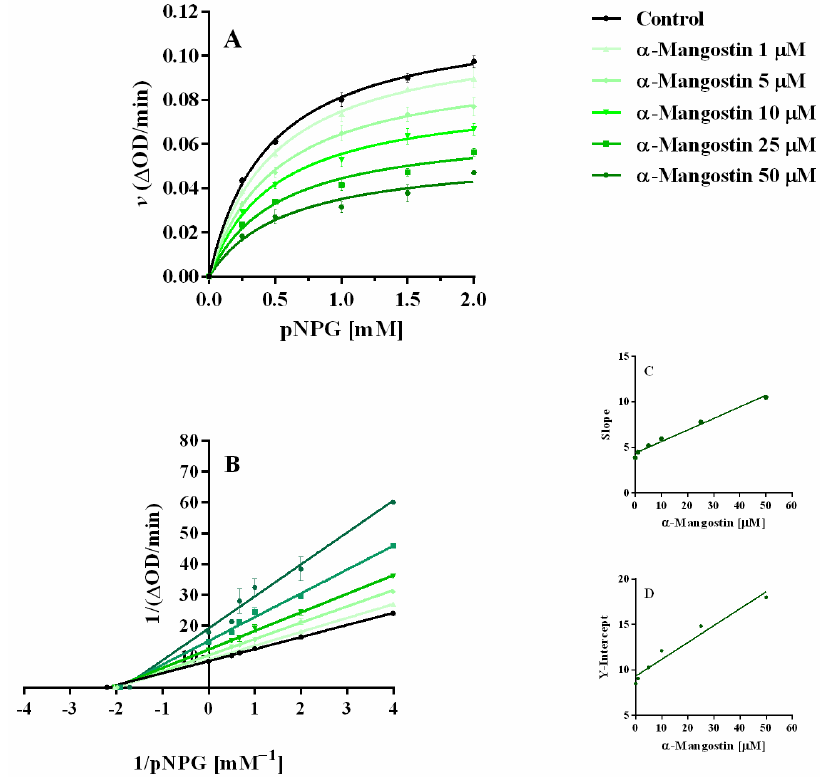
Figure 6. Michaelis–Menten and Lineaweaver–Burk graphs of α -mangostin ( A and B ) on α - Figure 6. Michaelis – Menten and Lineaweaver –Burk graphs of α -mangostin ( A and B ) on α -gluco- glucosidase activity with various concentrations of pNPG (0.25–2.0 mM). Graphs ( C and D) are sidase activity with various concentrations of pNPG (0.25 – 2.0 mM). Graphs ( C and D) are the sec- the secondary plots of “slope/y-intercept vs. [ α -mangostin]”. Data are expressed as mean ± SEM of ondary plots of “slope/y - intercept vs. [α - mangostin]”. Data are expressed as mean ± SEM of 3– 6 3–6 experiments. experiments. Table 2. Kinetic parameters of α - mangostin as inhibitor of α -glucosidase. Table 2. Kinetic parameters of α -mangostin as inhibitor of α -glucosidase. α